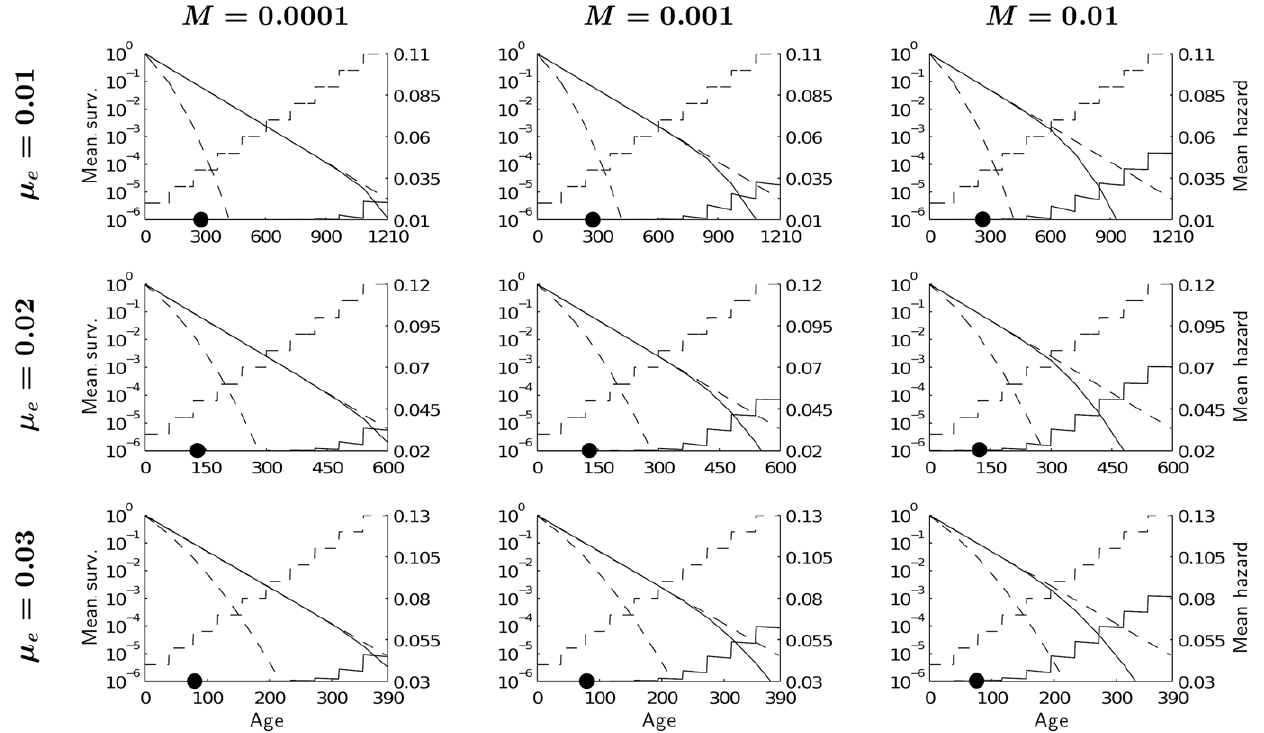
Figure 5. Age-dependence of mean hazard rate (solid lines with steps) and mean survivability (solid decreasing lines) given d =0.01 and l =0 for different levels of extrinsic mortality m e and mutation rate M . Dashed decreasing lines represent survivorship for non-mutated (upper lines) and maximally mutated genotypes (lower lines). The dashed lines with steps represent mortality of maximally mutated genotypes, while mortality of genotypes without mutations lies on the x-axis. Black dots represent mean age at maturity. For all cases the frequency of the maximaly mutated genotype is close to zero or numericaly equal to zero. Note that maximum age v is smaller the higher the level of environmental mortality m e .Thus, if m e =0.02, then v =600 and if m e =0.03, then v =390.